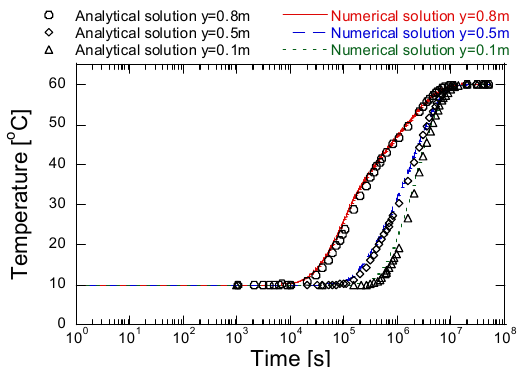
Figure 9. Schematic of thermal consolidation problem.